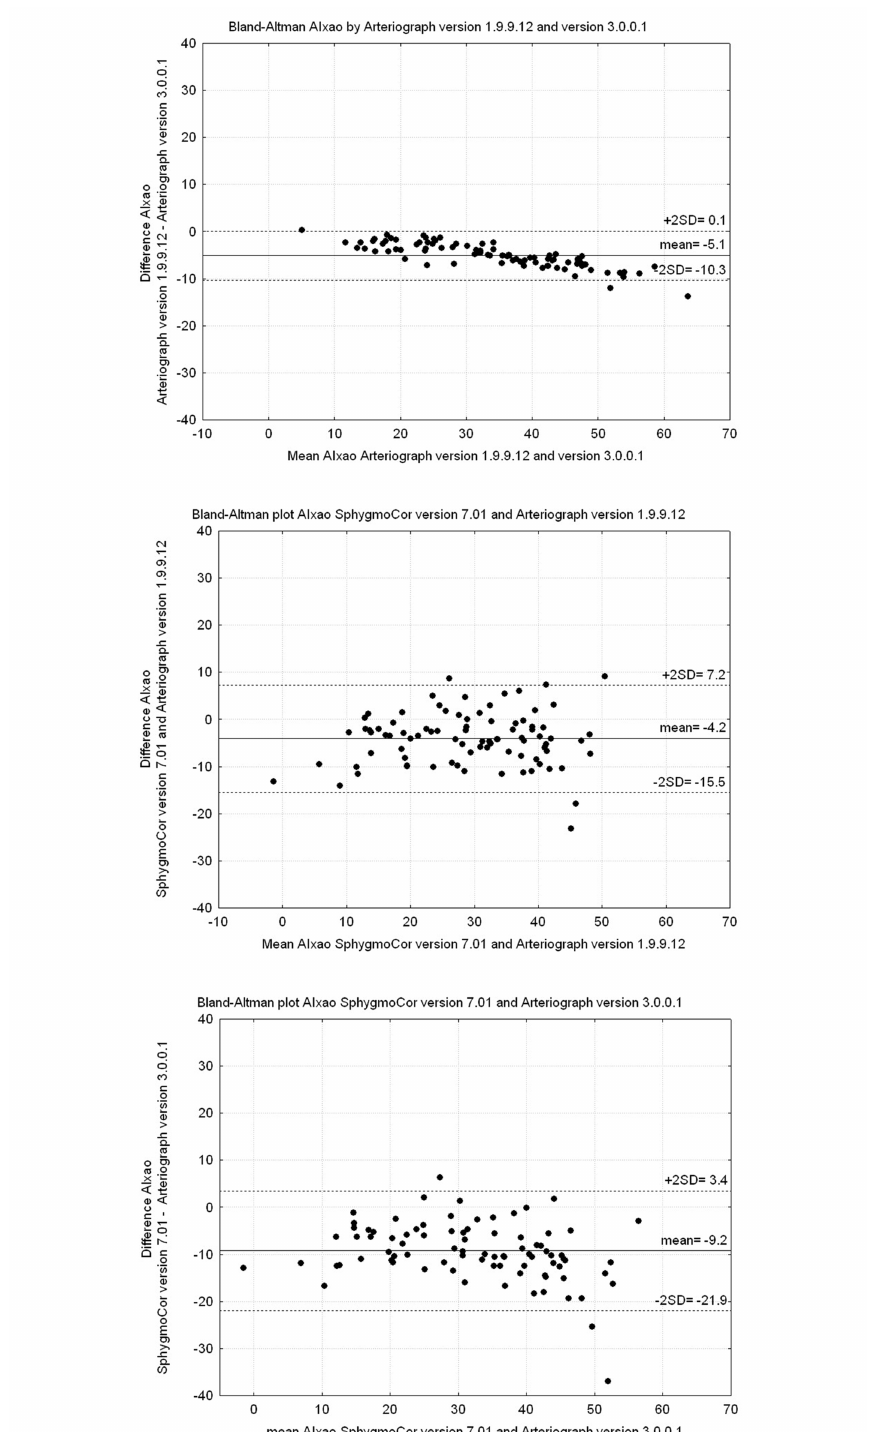
Fig 2. Bland-Altman plots showing AIxao. (Upper panel) Arteriograph v. 1.9.9.12 and v. 3.0.0.1. (Mid panel) SphygmoCor v. 7.01 and Arteriograph v. 1.9.9.12. (Lower panel) SphygmoCor v. 7.01 and Arteriograph v. 3.0.0.1.